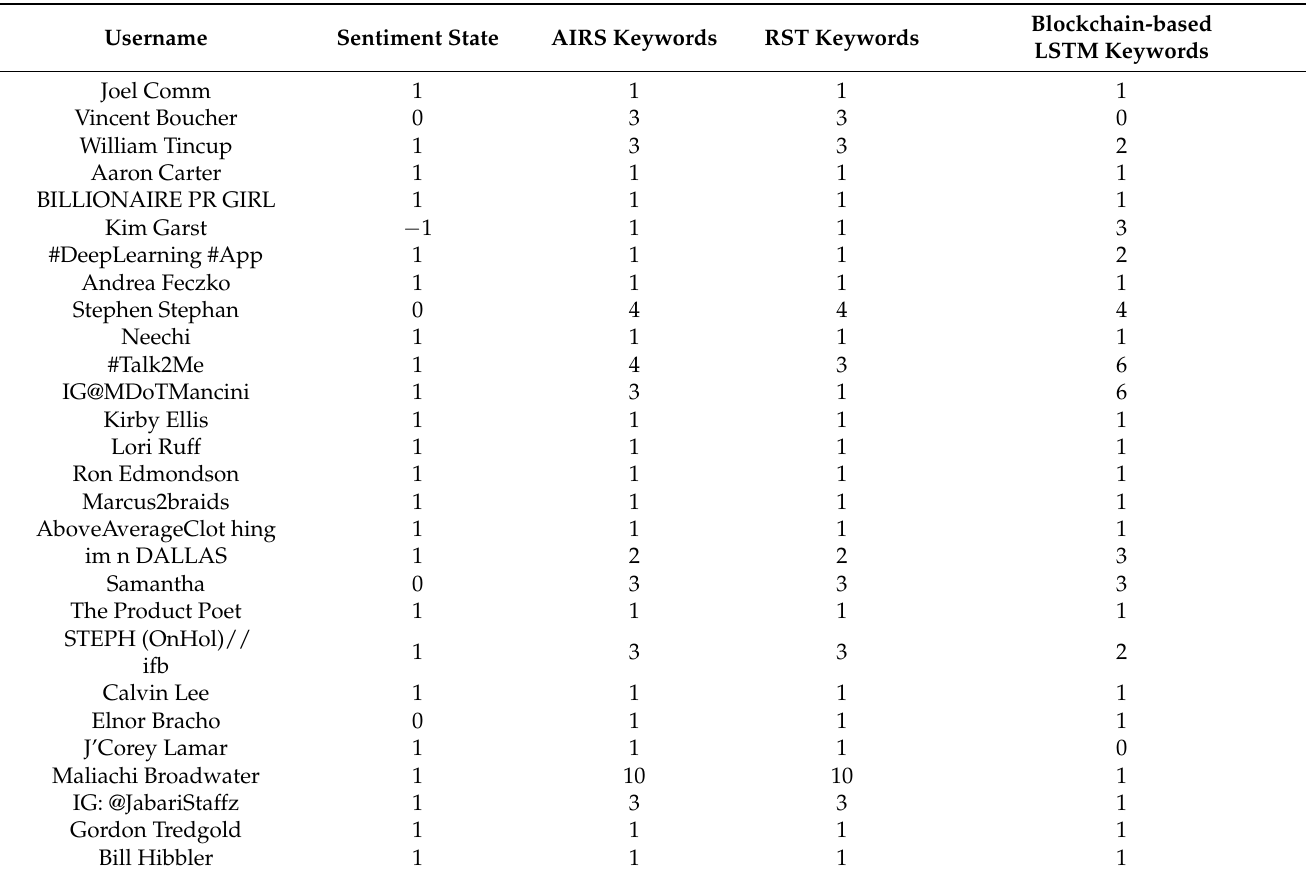
Table 9. Benchmark of sentiment data set keywords evaluation